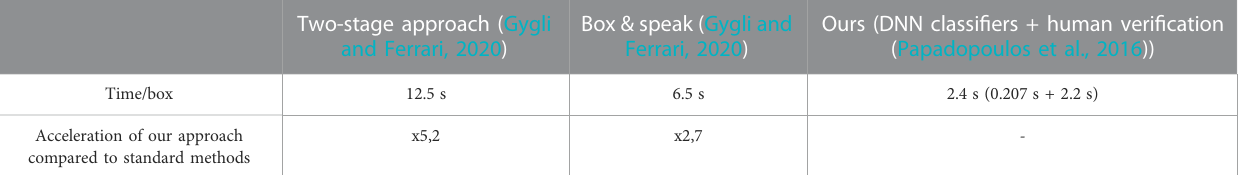
TABLE 5 Qualitative comparison of the presented automatic annotation approach with standard